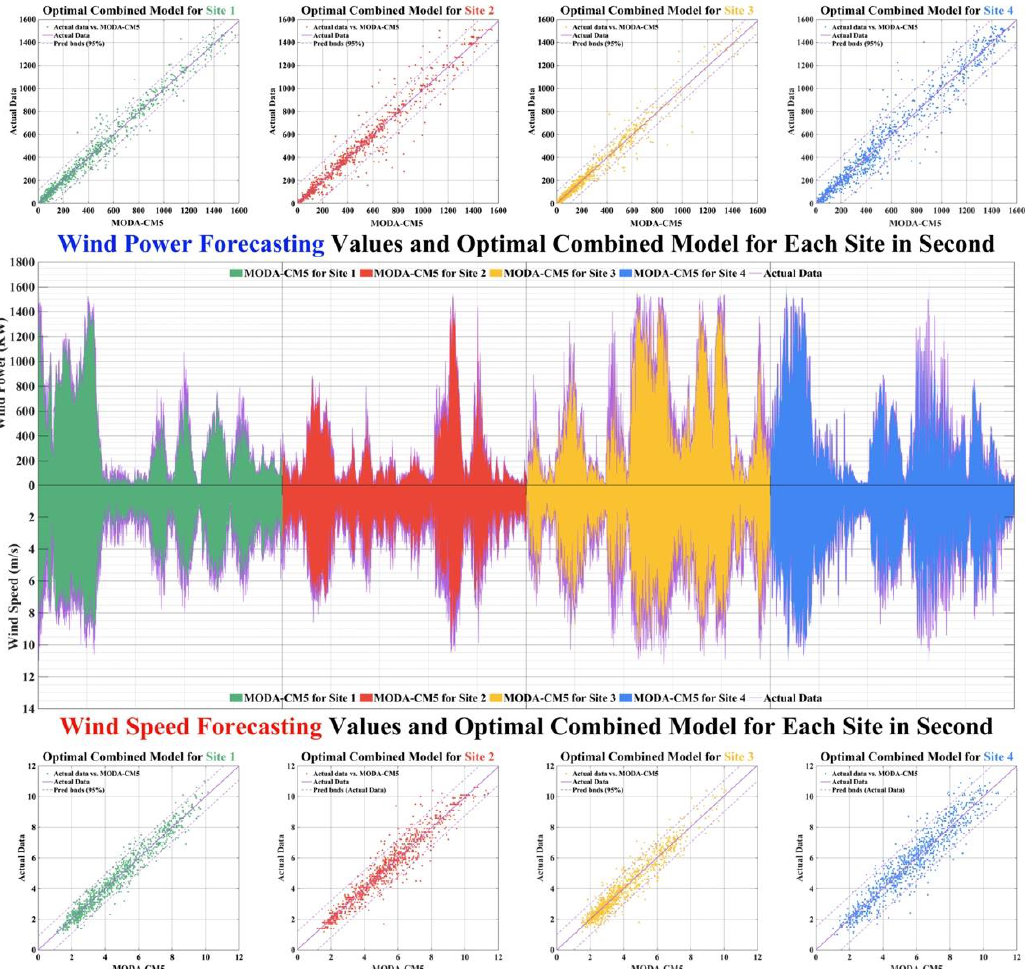
Figure 3. The optimal combined model for wind power and wind speed forecasting.